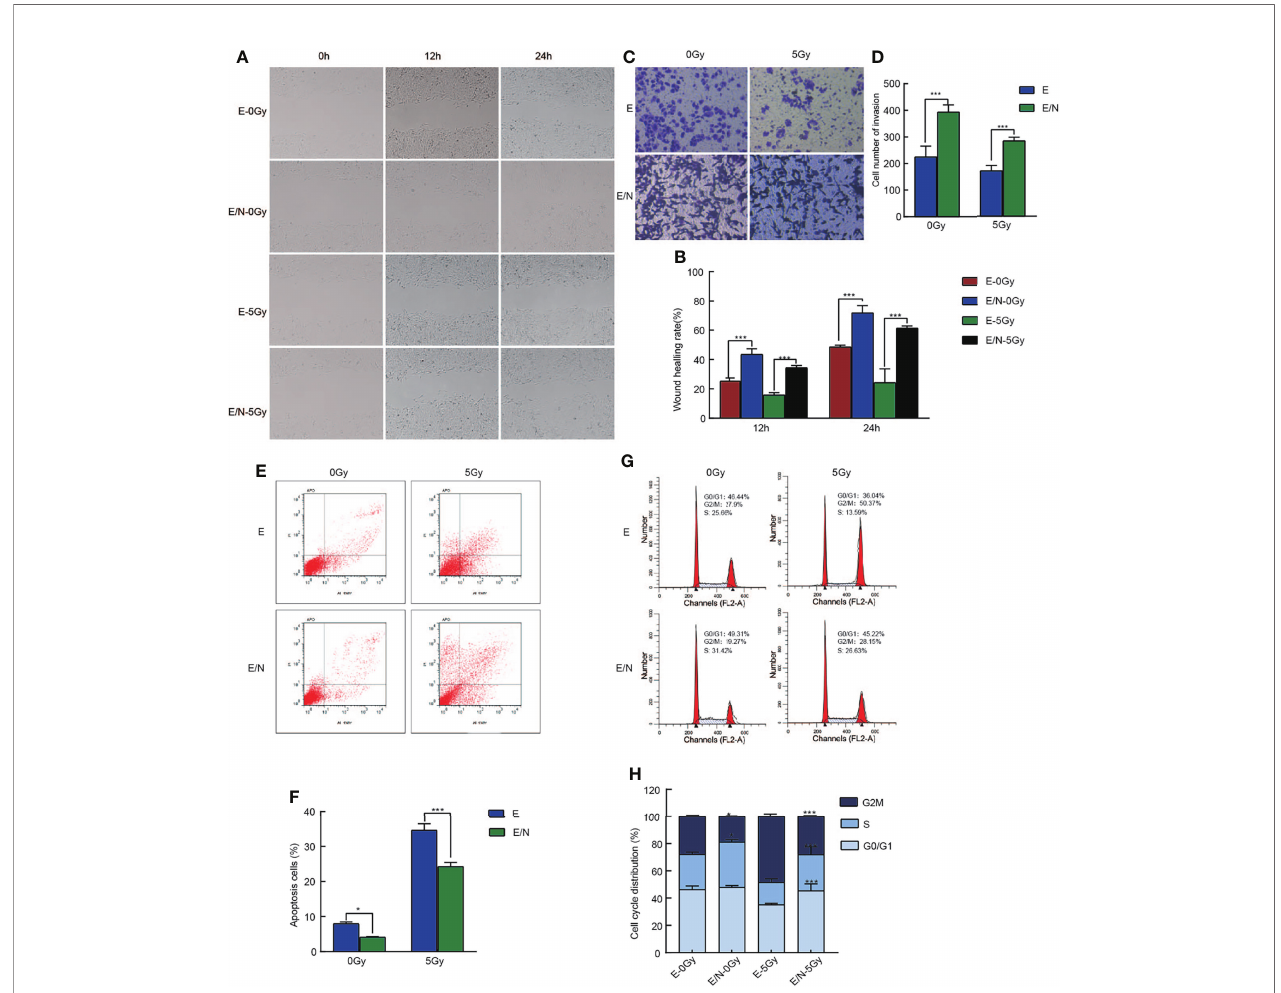
FIGURE 2 | Overexpression of NRAGE inhibits cell migration, invasion, cell cycle progression and apoptosis after IR in 2D culture. (A) Wound Healing assay was applied to test the migration ability of E and E/N with or without 5 Gy irradiation (magni fi cation: ×200); (B) Quantitative assessment of wound-healing rate at the different times (12 and 24 h); (C) Matrigel invasion assay was applied to compare E and E/N cells for invasion ability with or without 5 Gy irradiation (magni fi cation: ×200); (D) Quantitative assessment of the number of invasion cells. *P < 0.05 vs. E; **P < 0.01 vs. E; ***P < 0.005 vs. E; (E) Annexin V-FITC/PI staining was applied to test the apoptotic rates of E and E/N cells with or without 5 Gy IR by fl ow cytometry; (F) Quantitative assessment of the apoptotic rates; (G) Propidium iodide stain was applied to test cell cycle of E and E/N cells with or without 5 Gy IR by fl ow cytometric; (H) Cell cycle distributions were analyzed using GraphPad Prism 8.0 software; All data represented as means ± SD. * p < 0.05 vs. E; *** p < 0.001 vs.